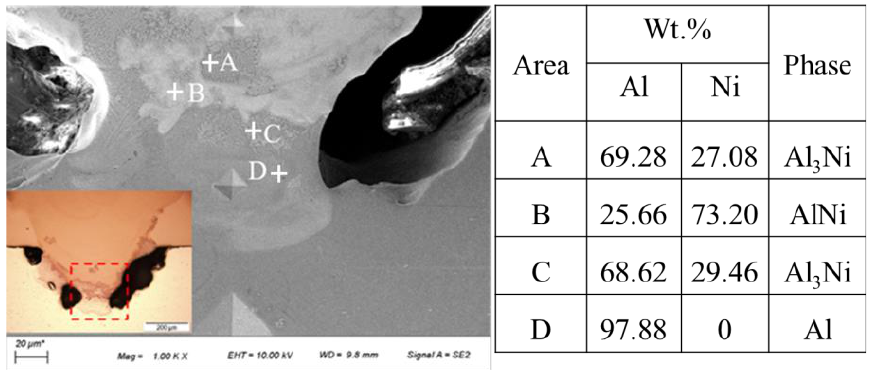
Figure 6. SEM image with high magnification, EDS results in areas A–D of the Al-Ni joint welded using a focused CW laser with 1800 W laser power.